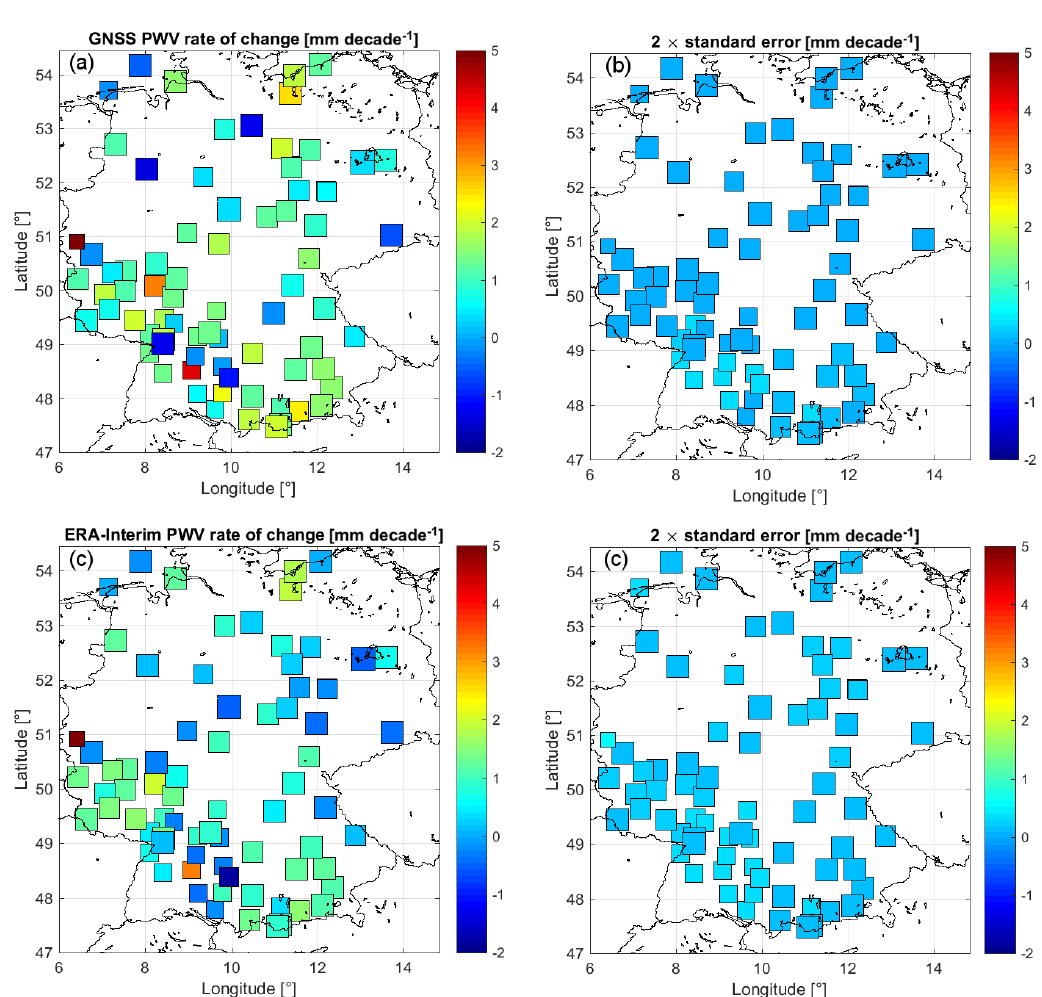
Figure 8. Validation of the PWV trend estimated from GNSS and ERA-Interim data using time series of at least 10-year-long